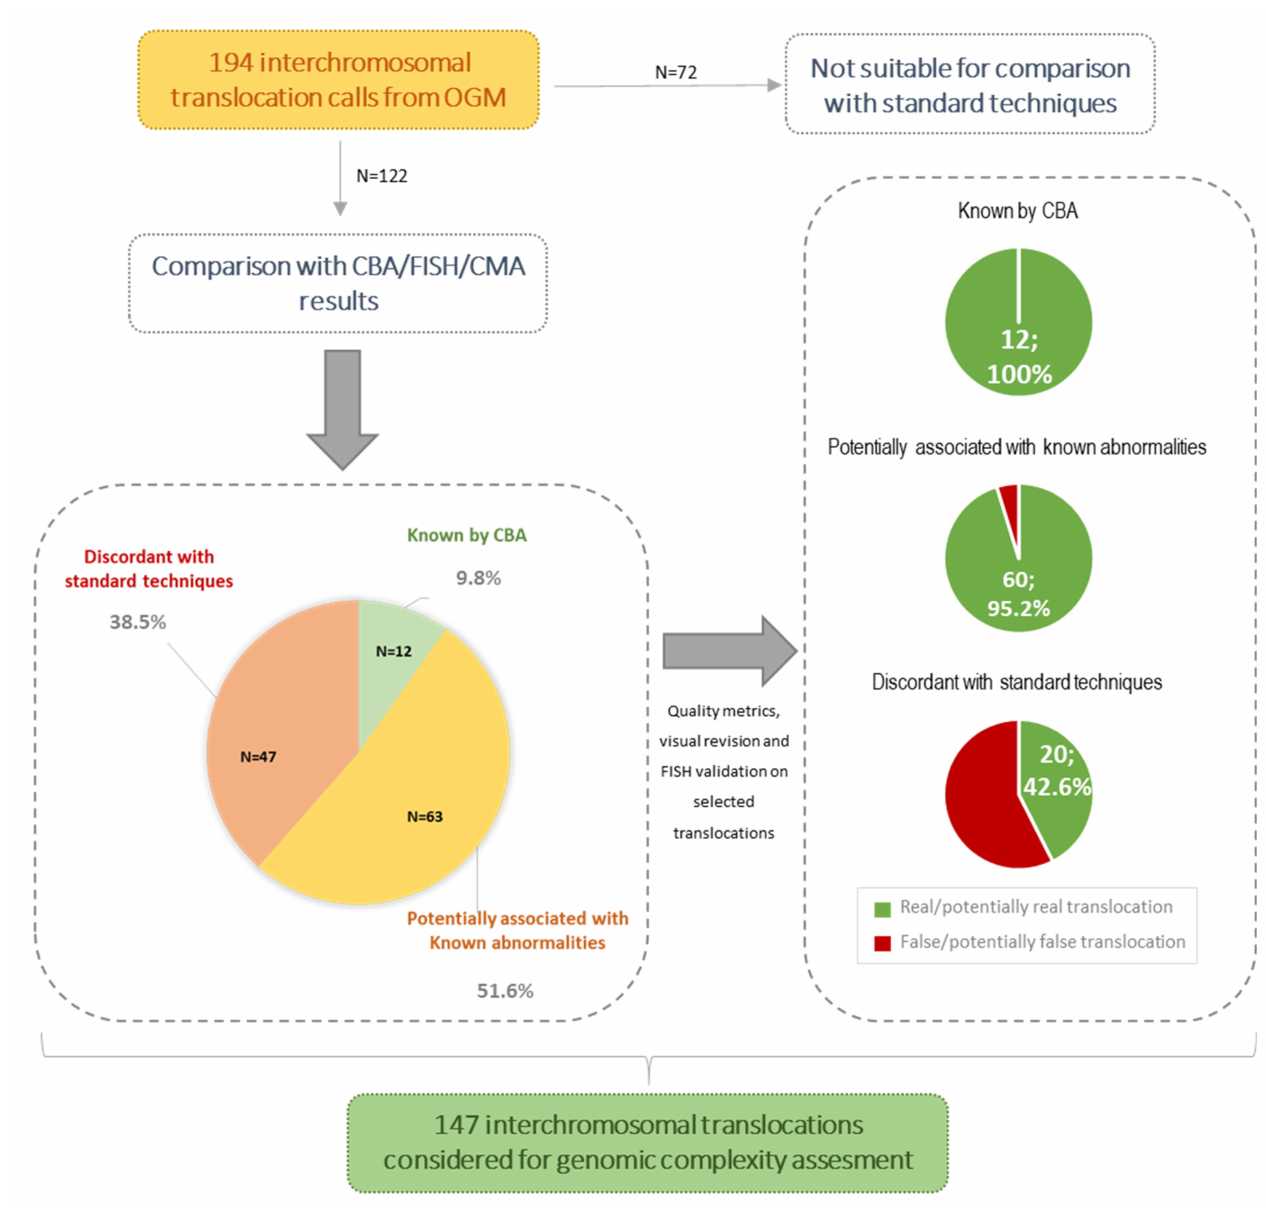
Figure 1. Summary of the analyses performed to define the final set of interchromosomal transloca- tions considered as real or potentially real in the present